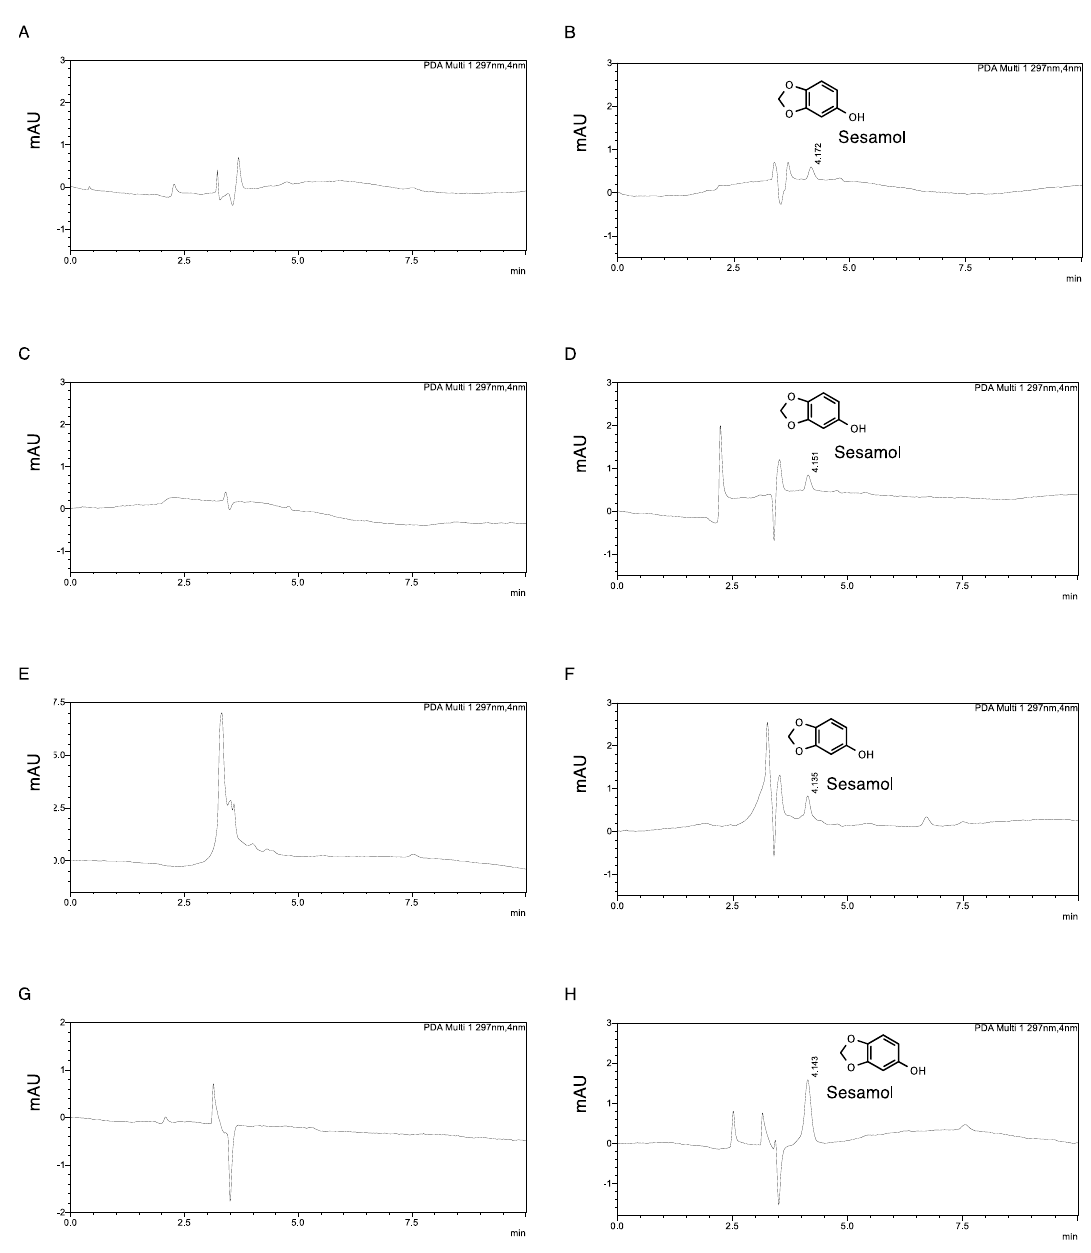
Figure 1. Chromatogram of sesamol in various solvents: ( A ) acetonitrile, ( B ) 20 ng/mL sesamol in acetonitrile, ( C ) 0.1 M sodium hydroxide, ( D ) 20 ng/mL sesamol in 0.1 M sodium hydroxide, ( E ) 100 mM hydrochloric acid, ( F ) 20 ng/mL sesamol in 100 mM of hydrochloric acid, ( G ) methanol, and ( H ) 20 ng/mL sesamol in methanol.